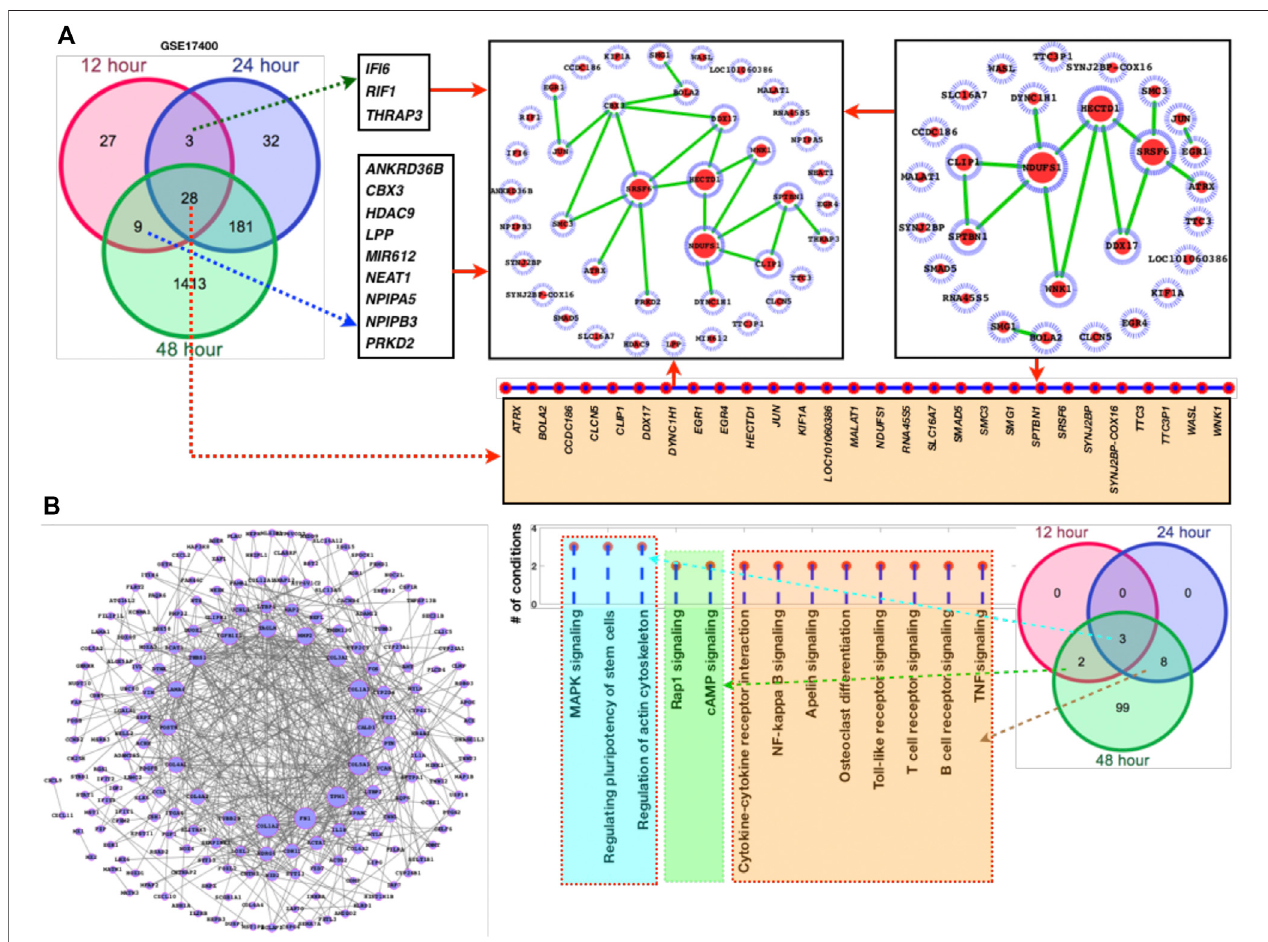
FIGURE2| DEGsnetworkandtheirrespectivefoldchangesandp-values. (A) VenndiagramfollowedbytheDEGsnetwork, (B) DEGs(181genessharedbetween 24 and 48 h) with their fold changes, (C) the enriched KEGG pathways followed by the venn diagram to display the alterations at different time points.